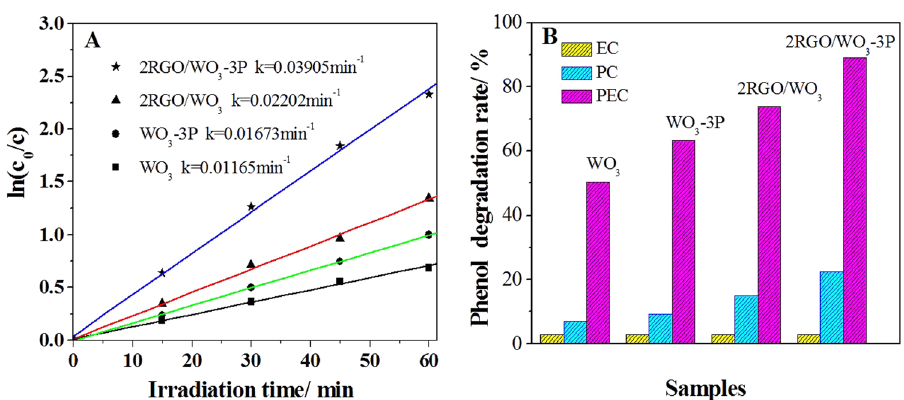
Figure 4. The degradation kinetic plots and corresponding rate constants of WO 3 , WO 3 -3P, 2RGO/WO 3 and 2RGO/WO 3 -3P for phenol degradation ( A ), and degradation rates of phenol in electrochemical (EC), photochemical (PC) and PEC systems ( B